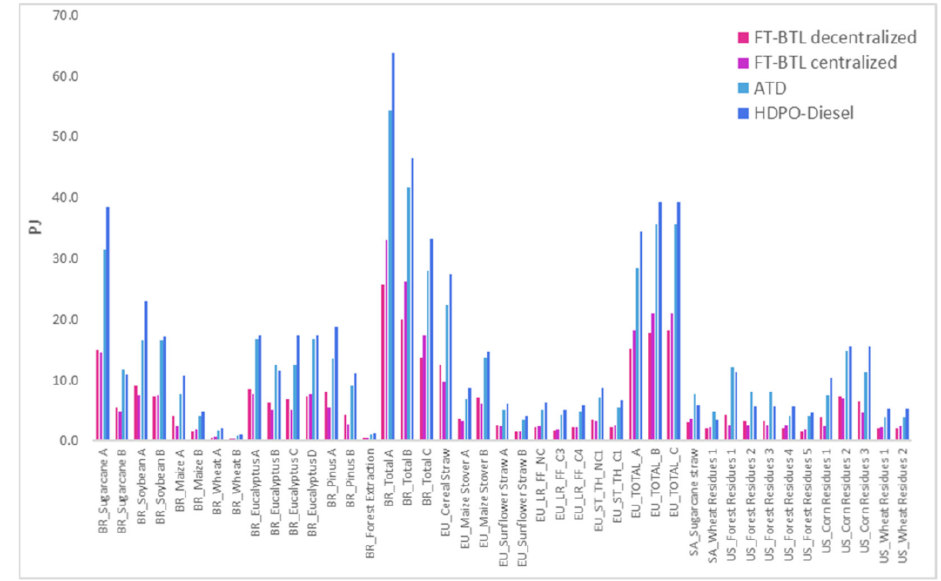
Figure 15. Biofuel production levels in each hotspot for FT-BTL, ATD, and HDPO pathways.